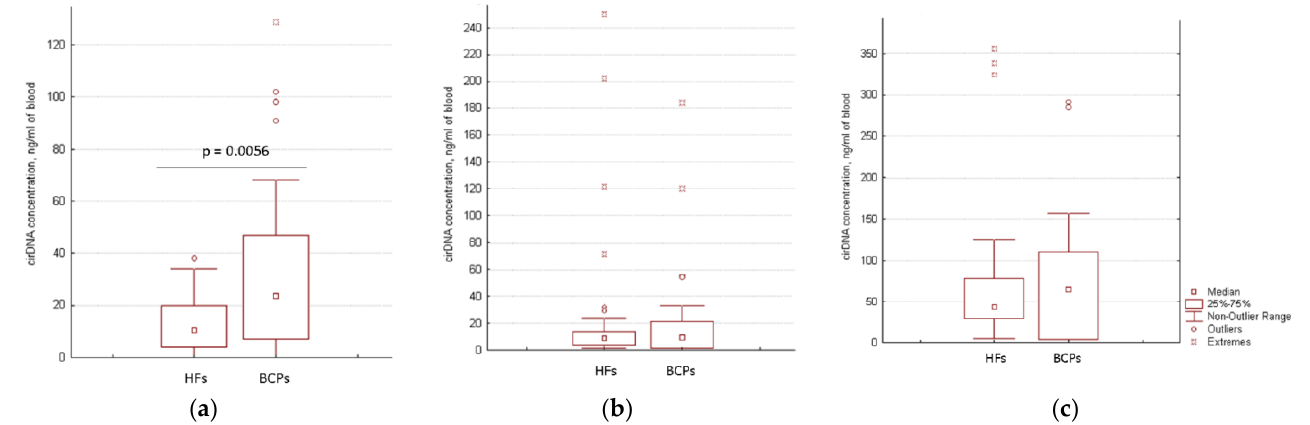
Figure 1. DNA concentration of different blood-circulating DNA fractions. ( a ) Plasma cfDNA; ( b ) csbDNA in PBS – EDTA eluate; ( c ) csbDNA in trypsin eluate. The data are recalculated to initial blood volume.